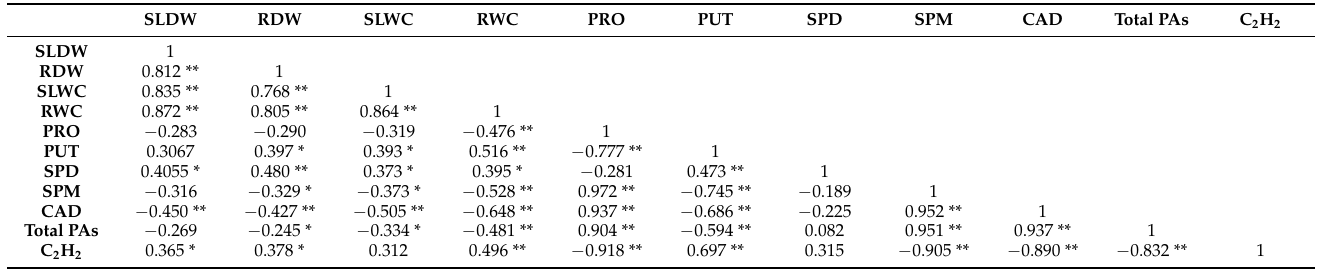
Table 5. Correlation coefficient among all parameters studied in F. pulverulenta cultivated in saline and non-saline conditions ( p ≤ 0.05 *; p ≤ 0.01